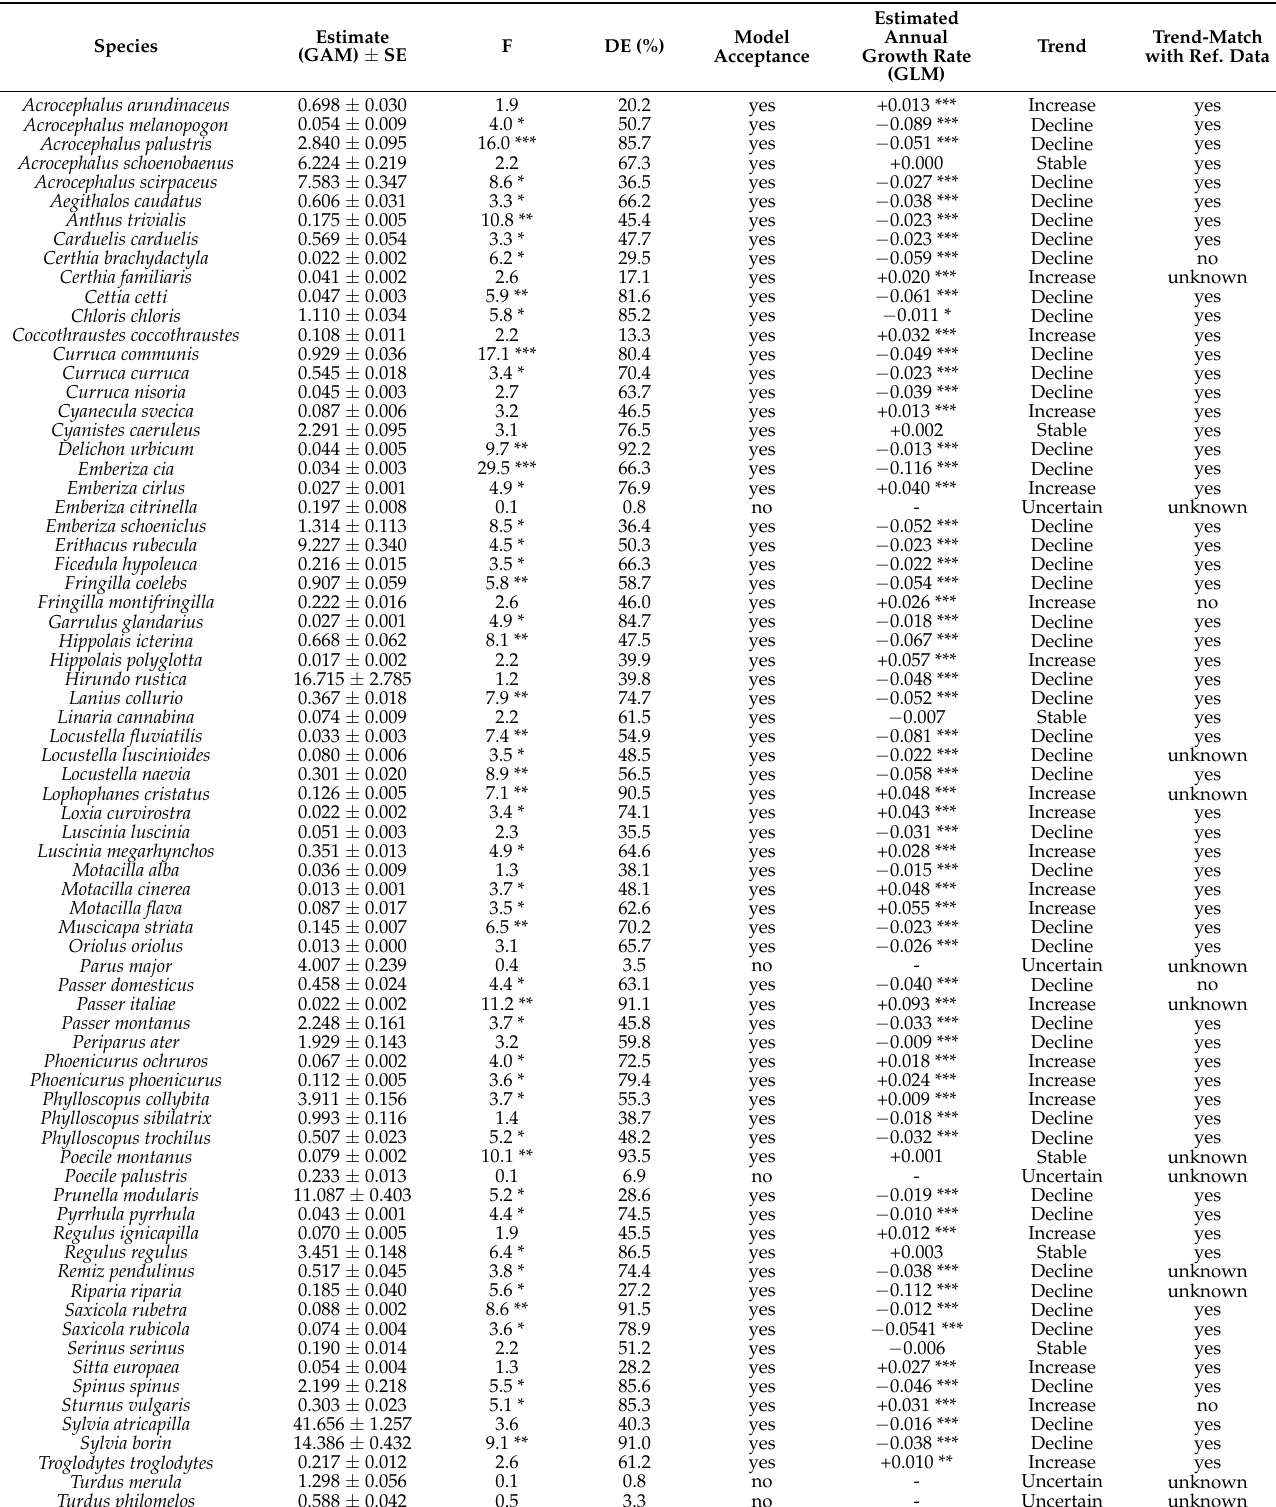
Table 2. General additive models (GAM) of population dynamics for the 74 passerine species. Estimated annual growth rate (trend) was assessed in a GLM. Reference data for trend-matching were [78,82,83]. Significant codes: *** p < 0.001, ** p < 0.01, * p < 0.05. Abbreviation: DE: deviance explained, SE: standard error.